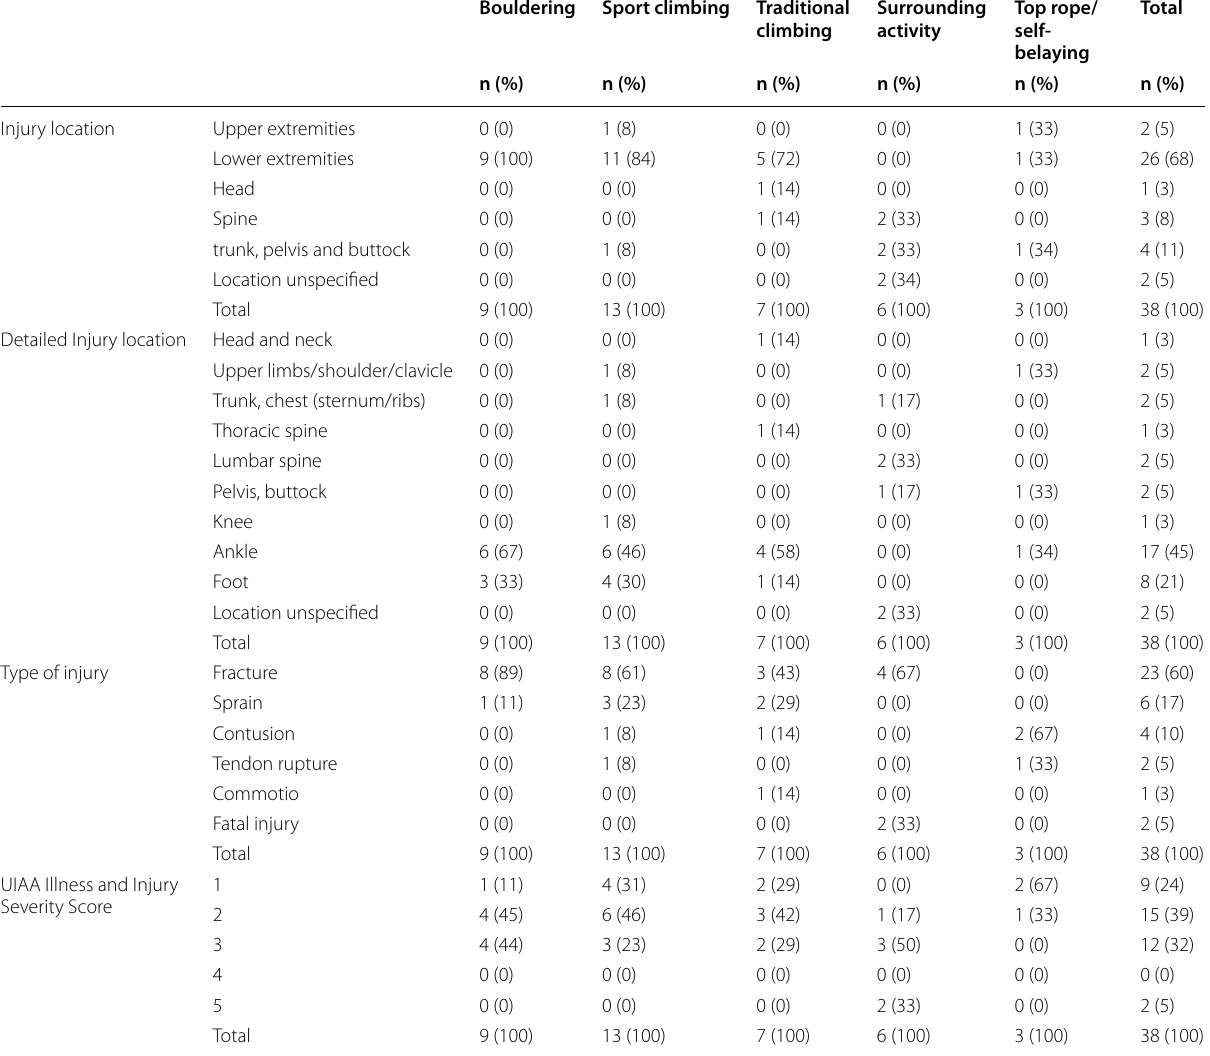
Table 2 Injury location, injury severity and type of injury for each climbing discipline